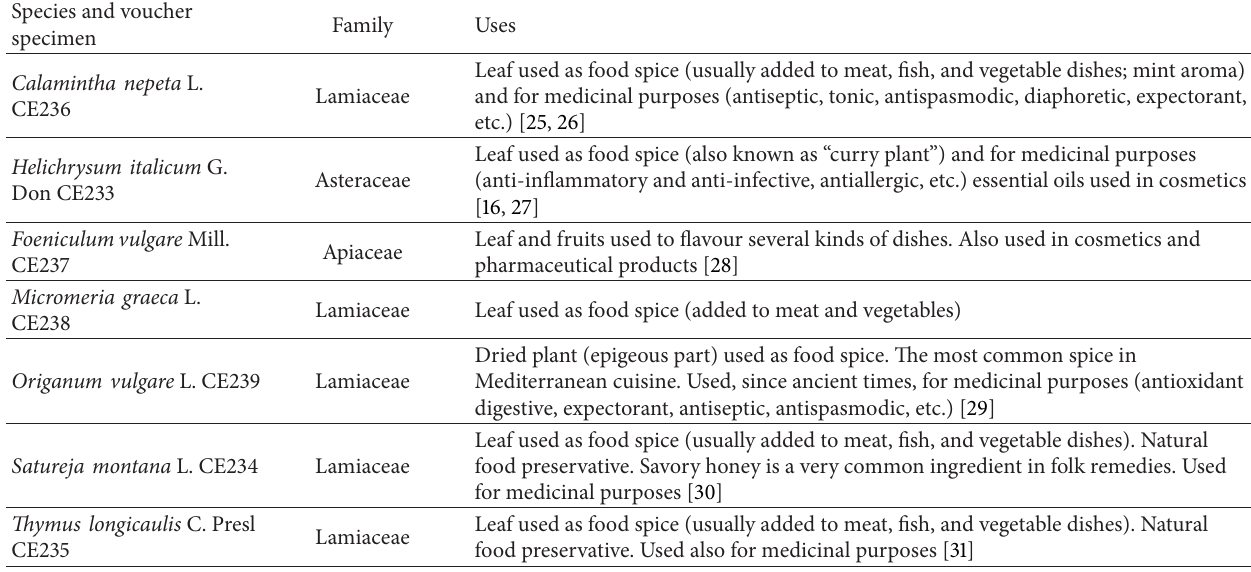
Table 1: Studied